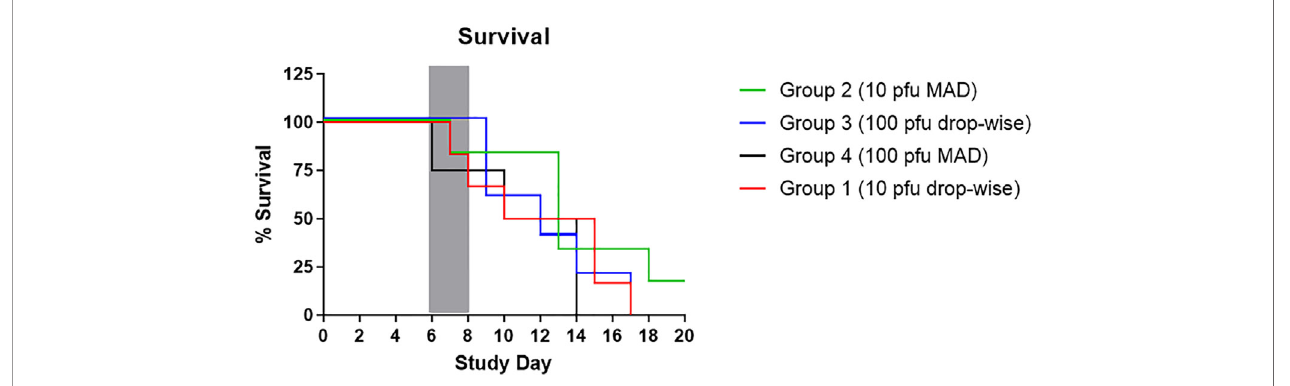
FIGURE 1 | Kaplan-Meier Survival Curve. The fi gure shows the percent survival by study group. The grey box indicated the typical death window for CM infected with 100 pfu of EBOV by the IM or AE routes.